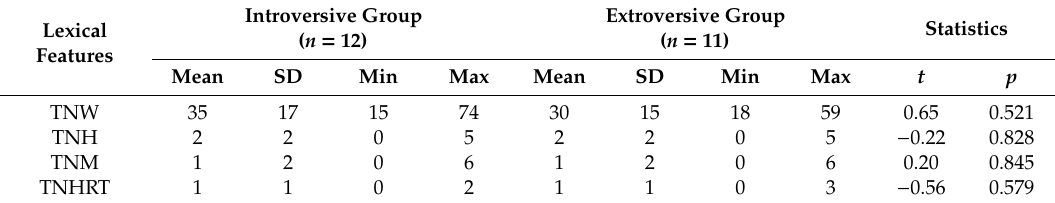
Table 3. Descriptive statistics of the lexical features of the introversive and extroversive groups. Lexical